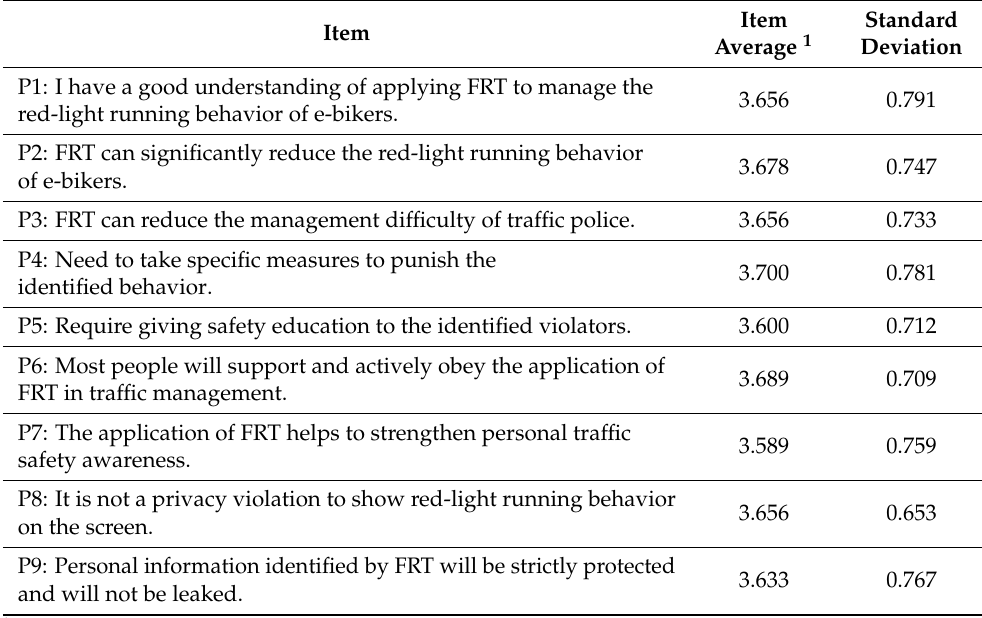
Table 8. Average and standard deviation of each item in the traffic police questionnaire, n = 90.